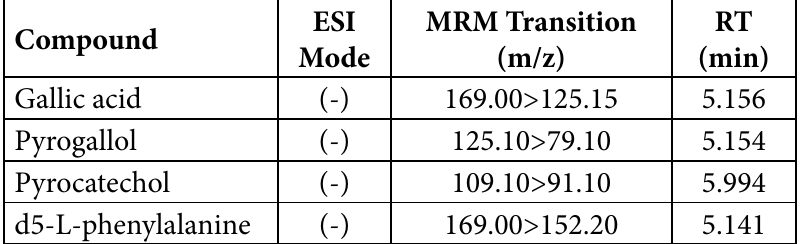
Supplementary Table 2. MRM transitions for compounds of interest as well as internal stan-